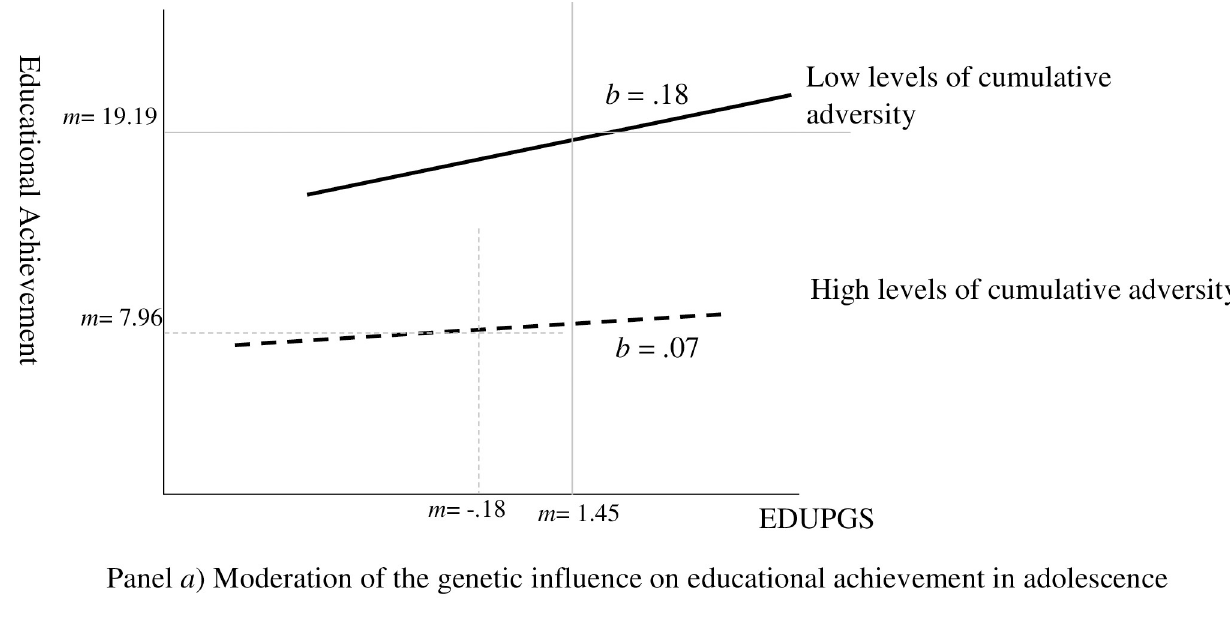
PLOS ONE | https://doi.org/10.1371/journal.pone.0256967 October 11,